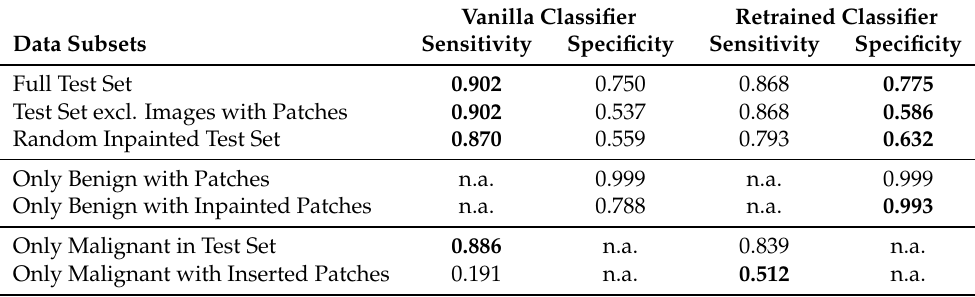
Table 1. Performance of classifiers on specific subsets of the test set when trained on the original training set (“Vanilla”) or trained on the augmented training set where coloured patches are inpainted (“Retrained”). Note that Sensitivity or Specificity are indicated with “n.a” when the specific data subset contains samples of only one class (benign resp.